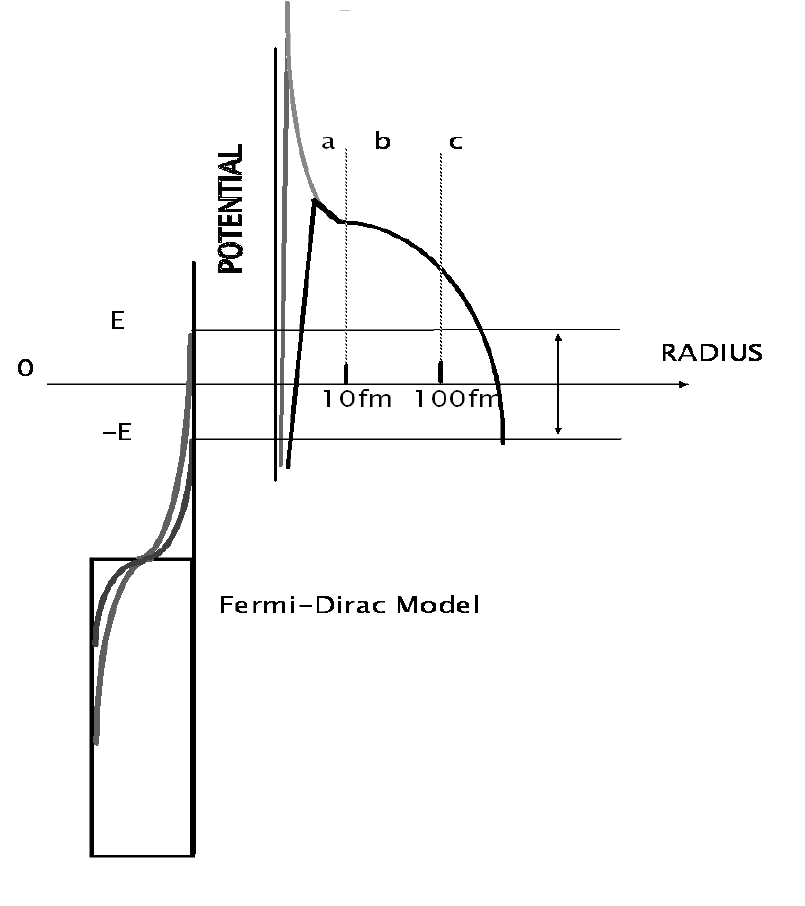
Figure 1. Typical potential of nucleus with intense laser. Gray line = well of nuclear potential with radius of 5 fm; black line = nuclear potential shifted due to mesons; b = region where Coulomb barrier is dominant; c = region where laser field is